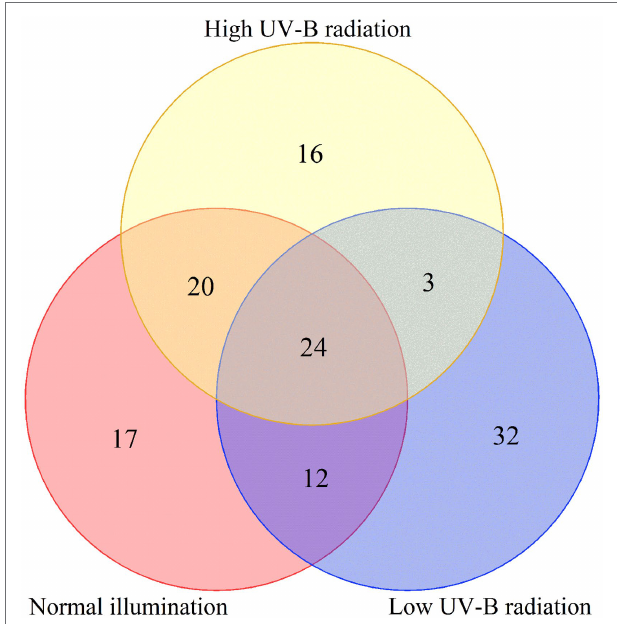
FIGURE 3 | Venn diagram of differential metabolites under different UV-B radiation